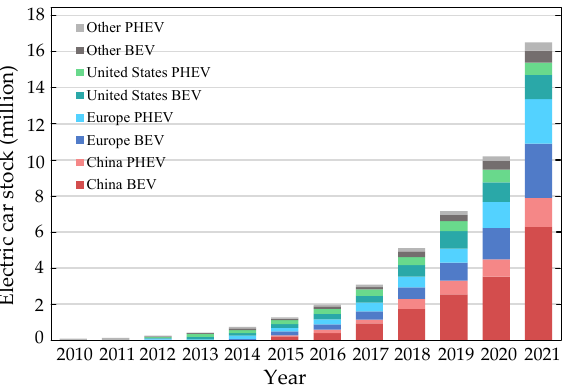
Figure 1. Global electric vehicle inventory (2010–2021).